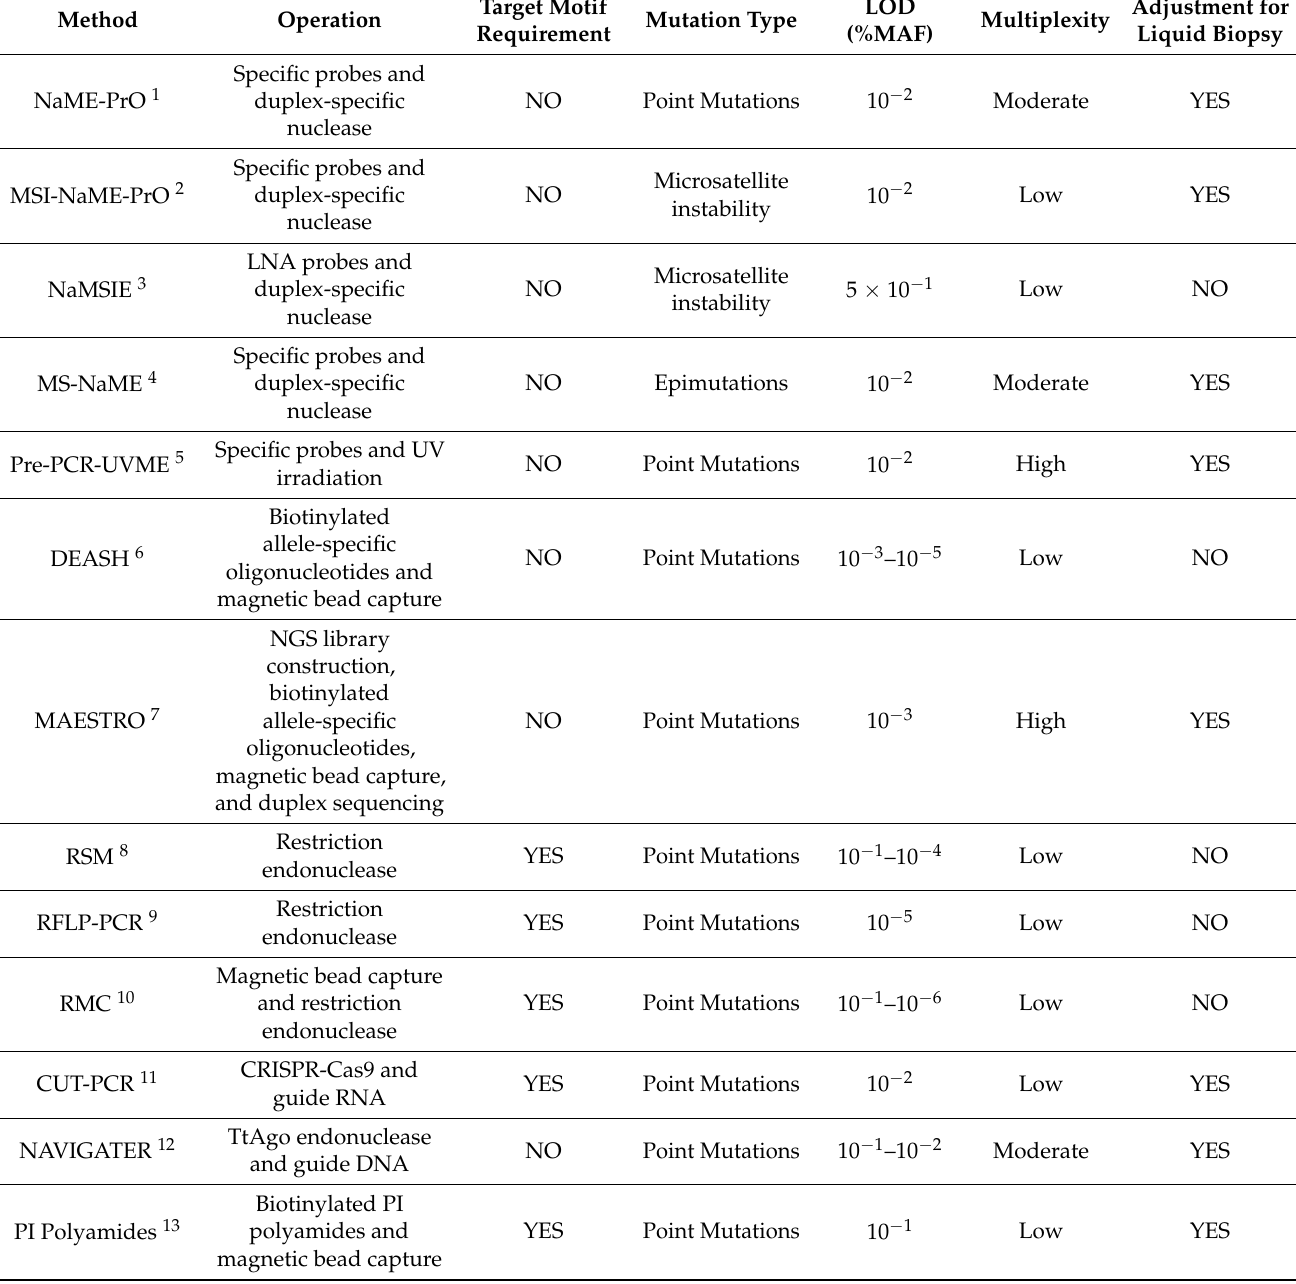
Table 1. Pre-PCR mutation-enrichment techniques for liquid biopsy. LOD—limit of detection; MAF—mutant allelic